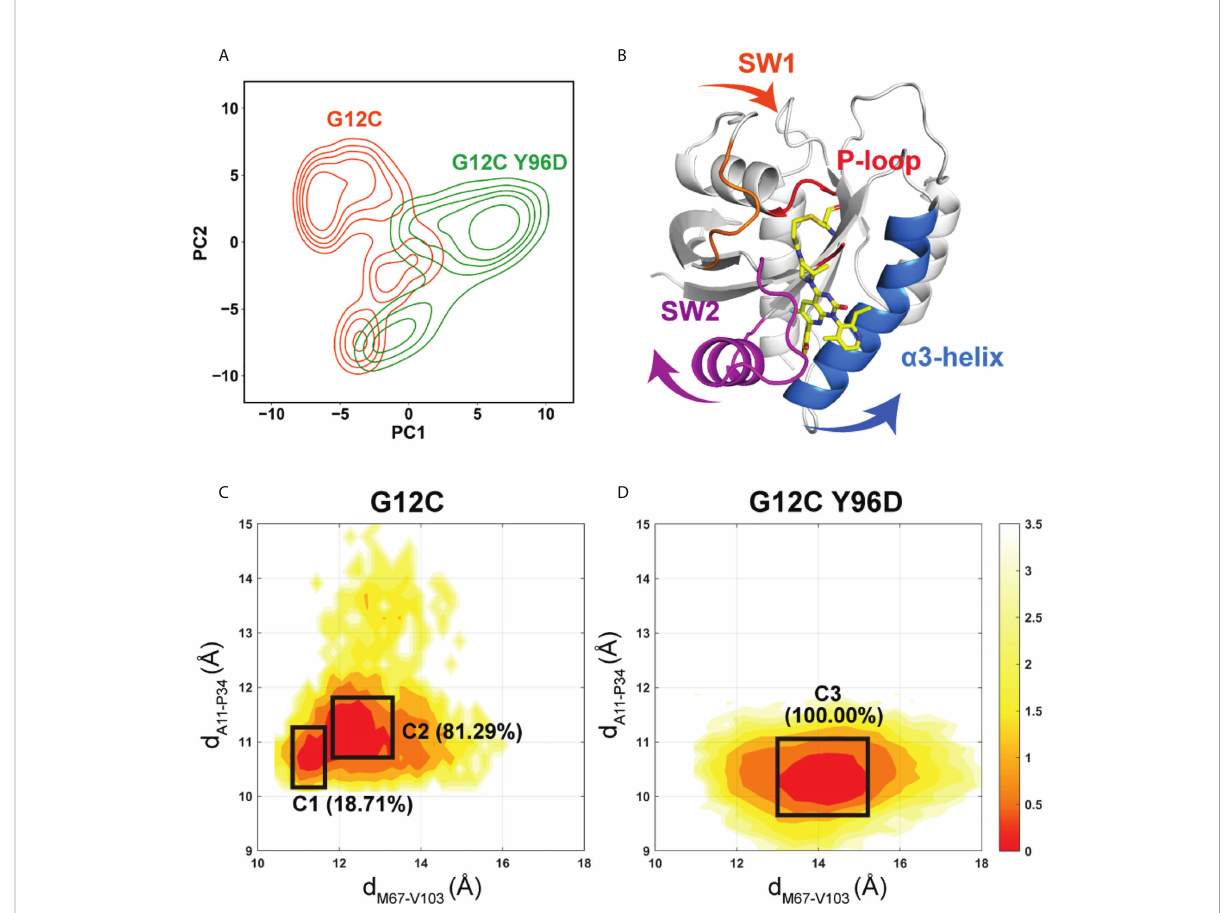
FIGURE 2 Global conformational transition of the KRAS protein. (A) Projections of the fi rst and second principal components (PC1 vs PC2) from MD simulations of the G12C system (orange) and the G12C/Y96D system (green). (B) The motion along the PC1. Conformational landscapes generated using the d M67-V103 (distance from the M67 C a atom to the V103 C a atom) and d A11-P34 (distance from the A11 C a atom to the P34 C a atom) order parameters in the G12C system (C) and the G12C/Y96D system (D)